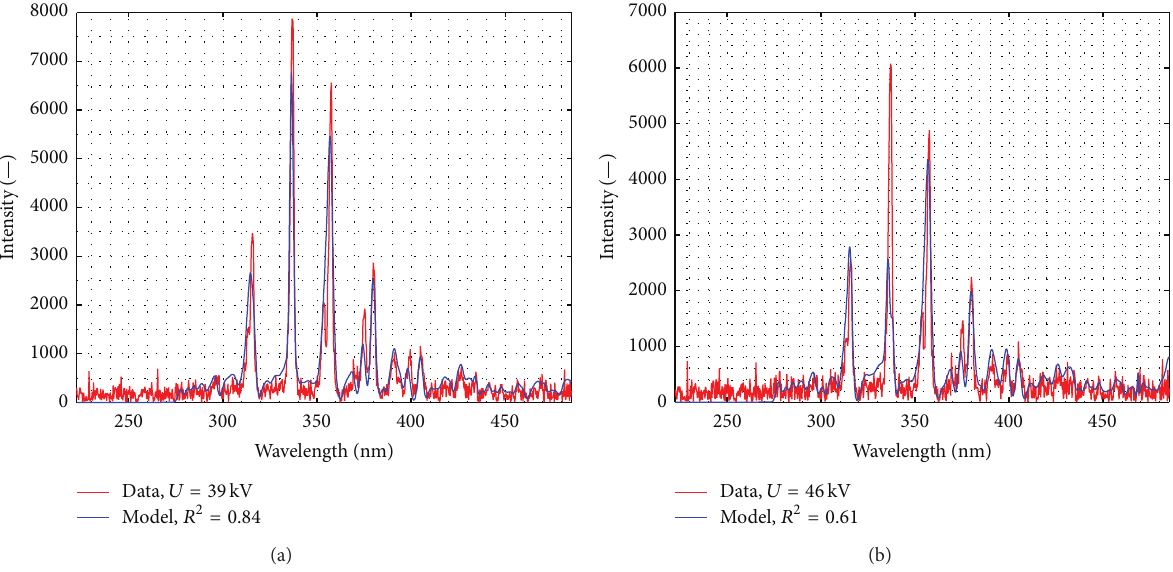
Figure 18: Intensity spectra of recorded and modeled light emission for selected values of PD generation voltages: (a) 0.81 𝑈 𝑝 = 39 kV and (b) 0.95 𝑈 𝑝 = 46 kV.